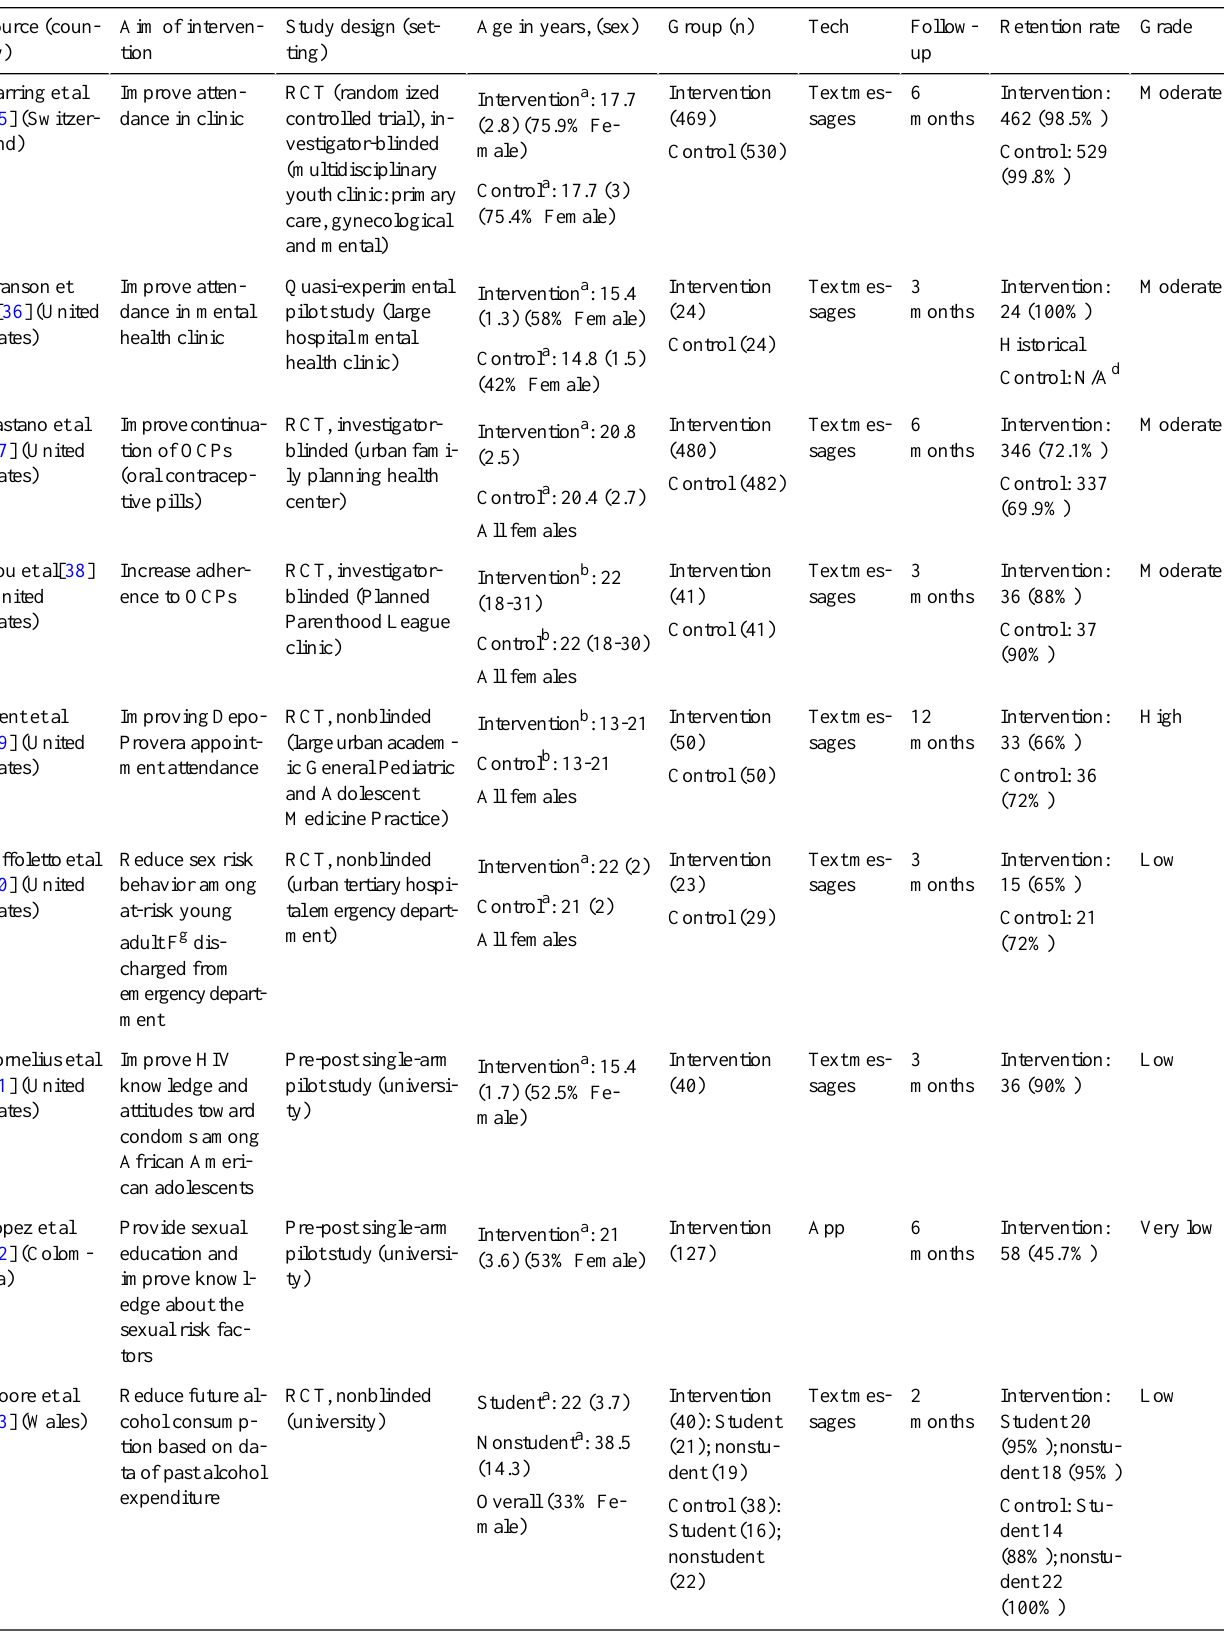
Table 1. Summary of included studies focused on improving adherence to preventive measures in